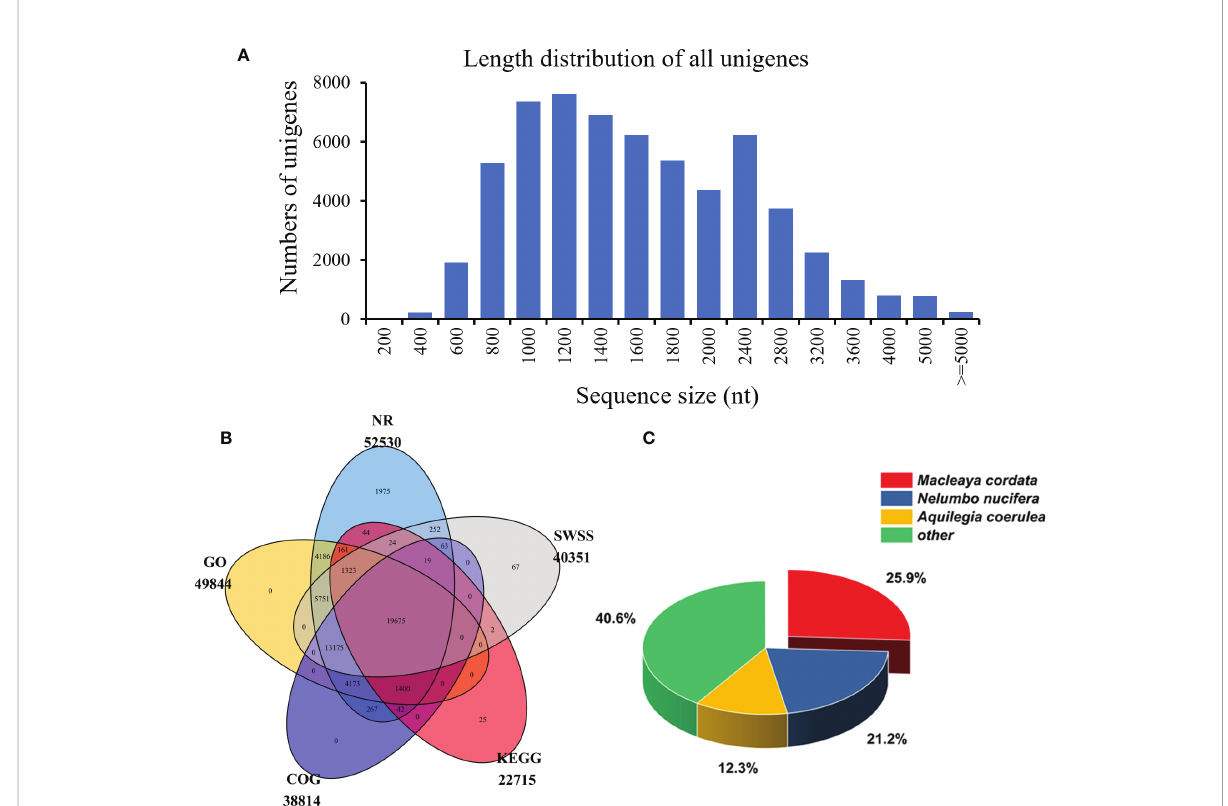
FIGURE 2 The length distribution and functional annotation of the unigenes in S. acutum . (A) Length distribution of the 60,675 unigenes. (B) Annotated unigenes from different public databases. (C) NR homologous species distribution